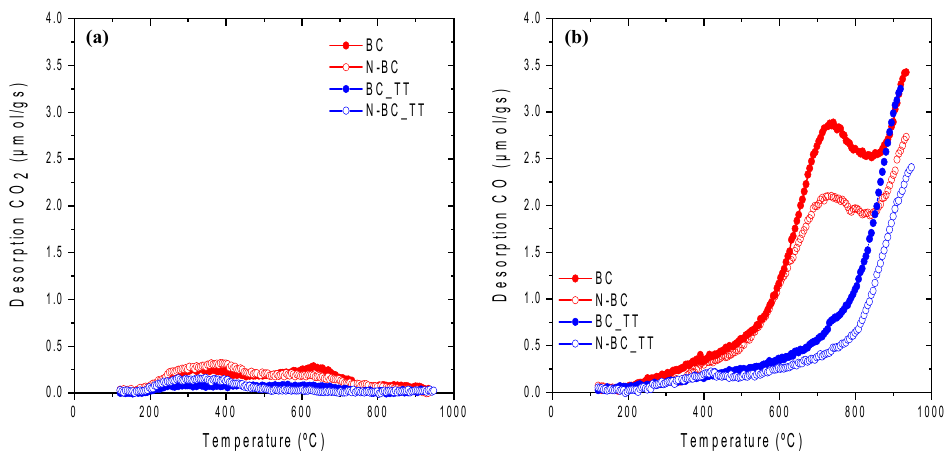
Figure 3. TPD profiles for all carbon supports ( a ) CO 2 -evolving groups and ( b ) CO-evolving groups. Table 2. Surface chemistry of the soft-biomass derived carbon supports.